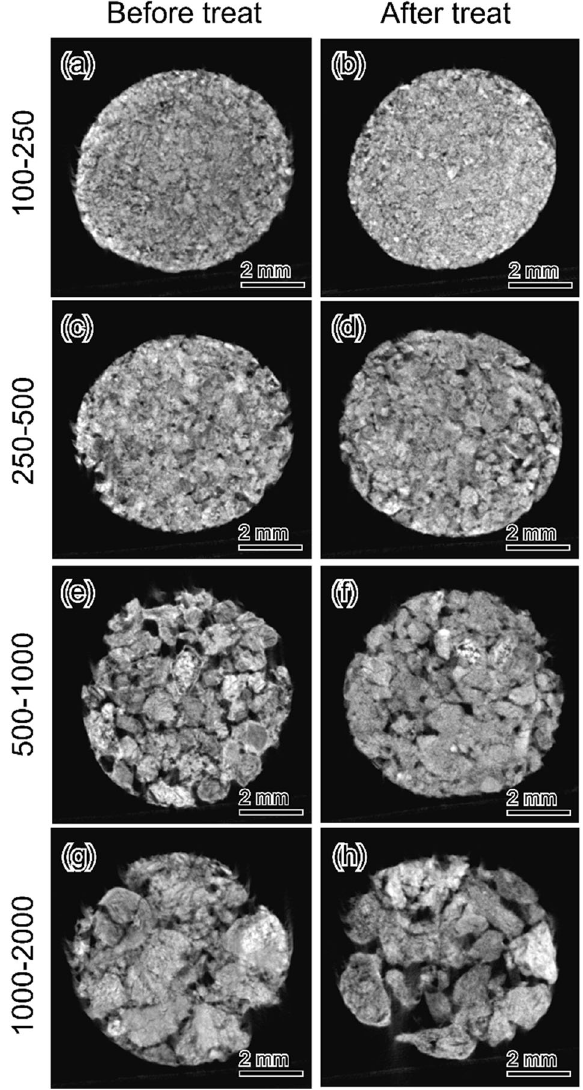
Fig. 1 Representative photographs of acidic calcium phosphate foams before ( a – d ) and after ( e – h ) immersion